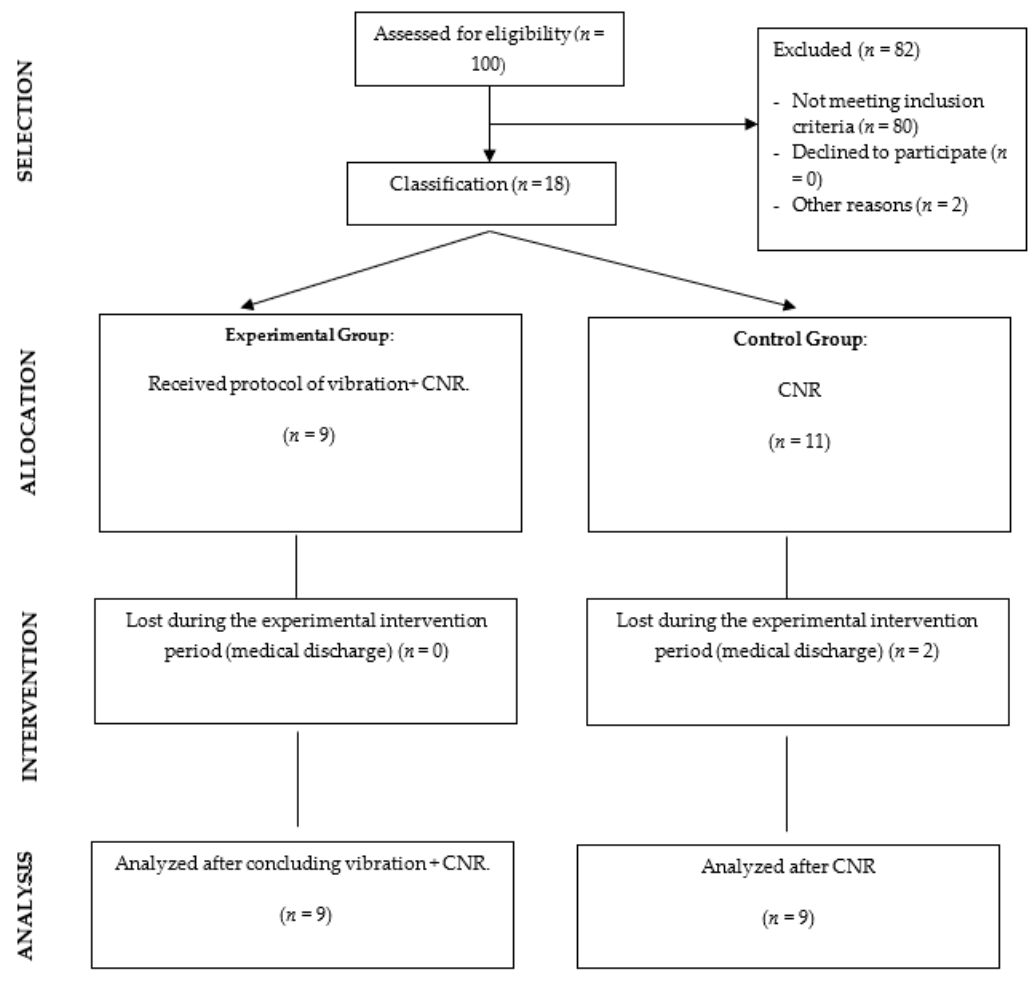
Figure 1. Flow diagram. Table 1. Socio-demographic characteristics of the